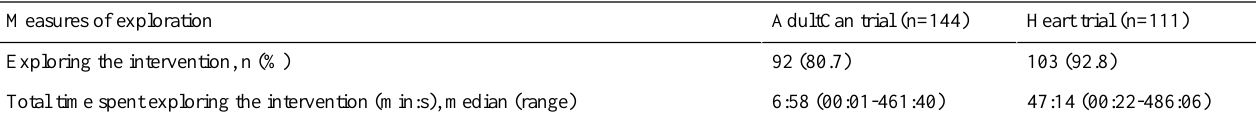
Table 4. Number of participants in the treatment group exploring the intervention within 14 days after randomization and their time spent on exploring.